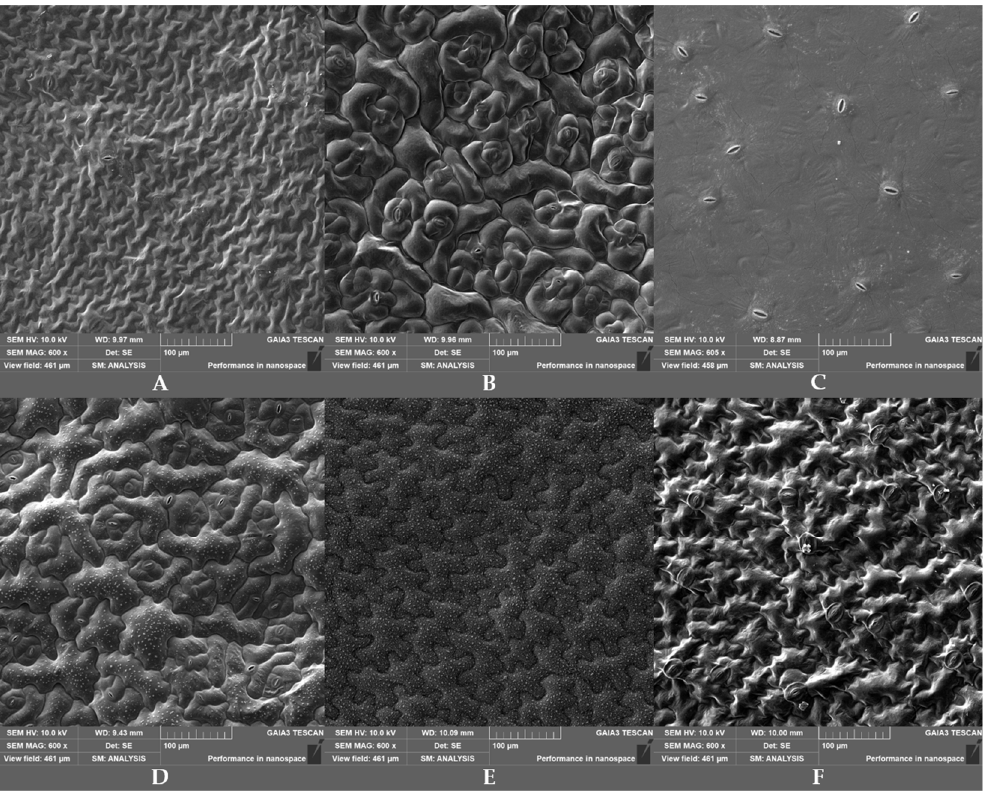
Figure 3. A rough estimate of the Ra parameter can be obtained considering the differences between the maximum and minimum height values, which are higher in ‘Bionda degli Ortolani’ (Figure 3A) and lower in lamb’s lettuce ‘Trophy F1 (cid:48) (Figure 3F). The Pearson’s test revealed a significant correlation between contamination level and both Ra and Rq values (Figure 4A,B).